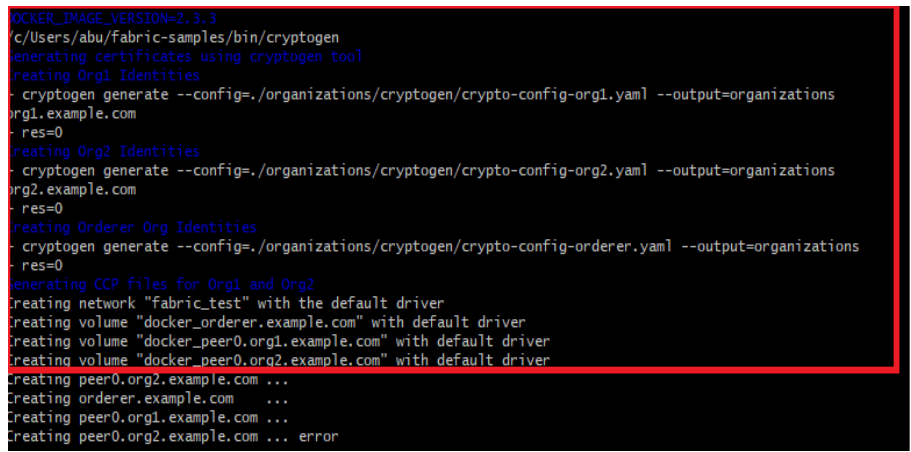
Figure 19 . Create docker engine.